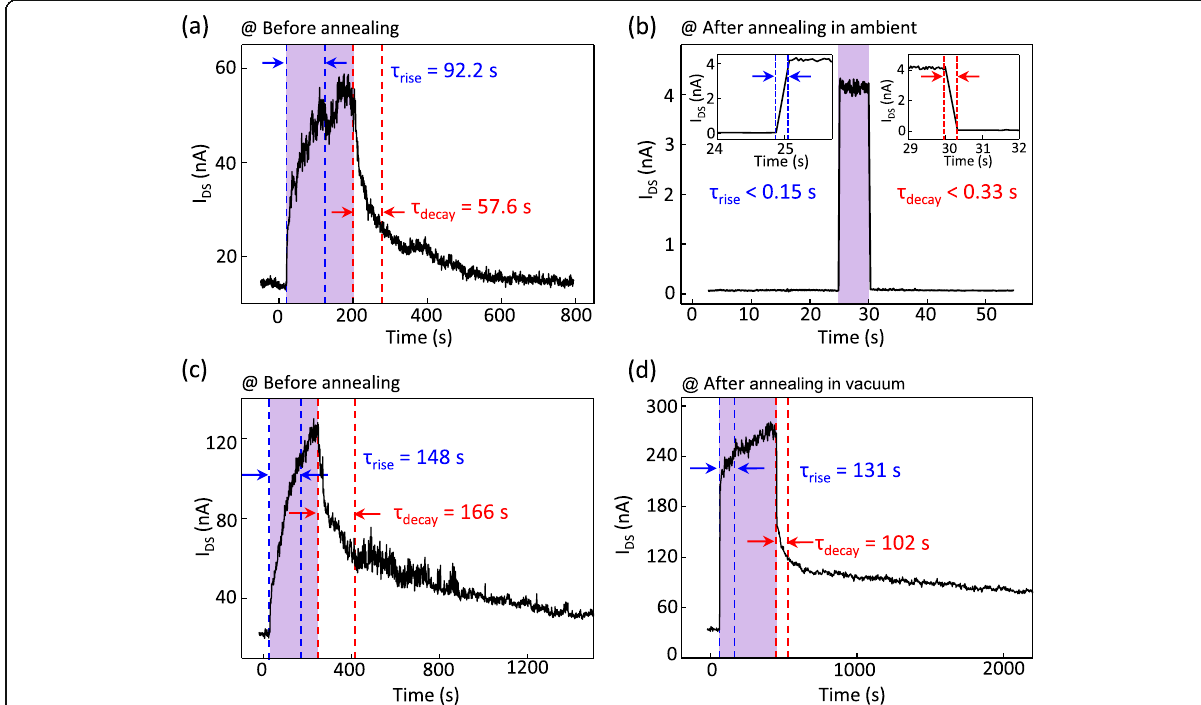
Fig. 3 Photoswitching responses of ambipolar WSe 2 FETs a , c before and after annealing b in ambient at 200 °C for 1 h and d in vacuum, respectively. All data were measured at V GS = 0 V and V DS = 10